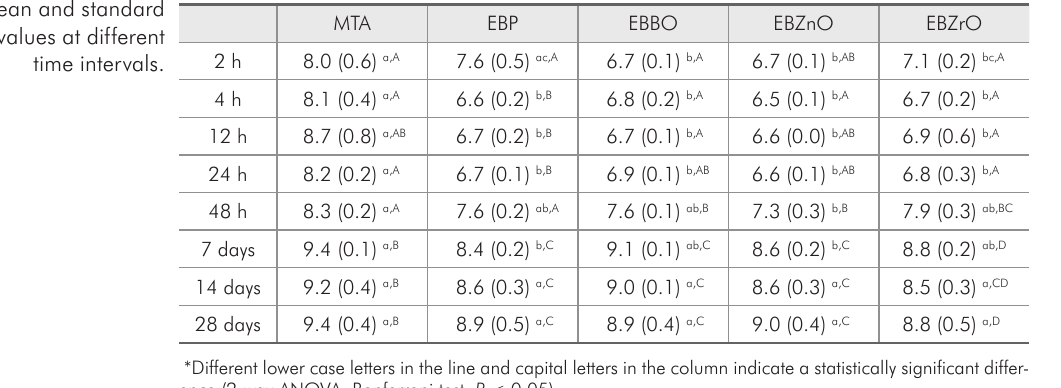
Figure 1 - Graphic representation of the pH mean values at different time